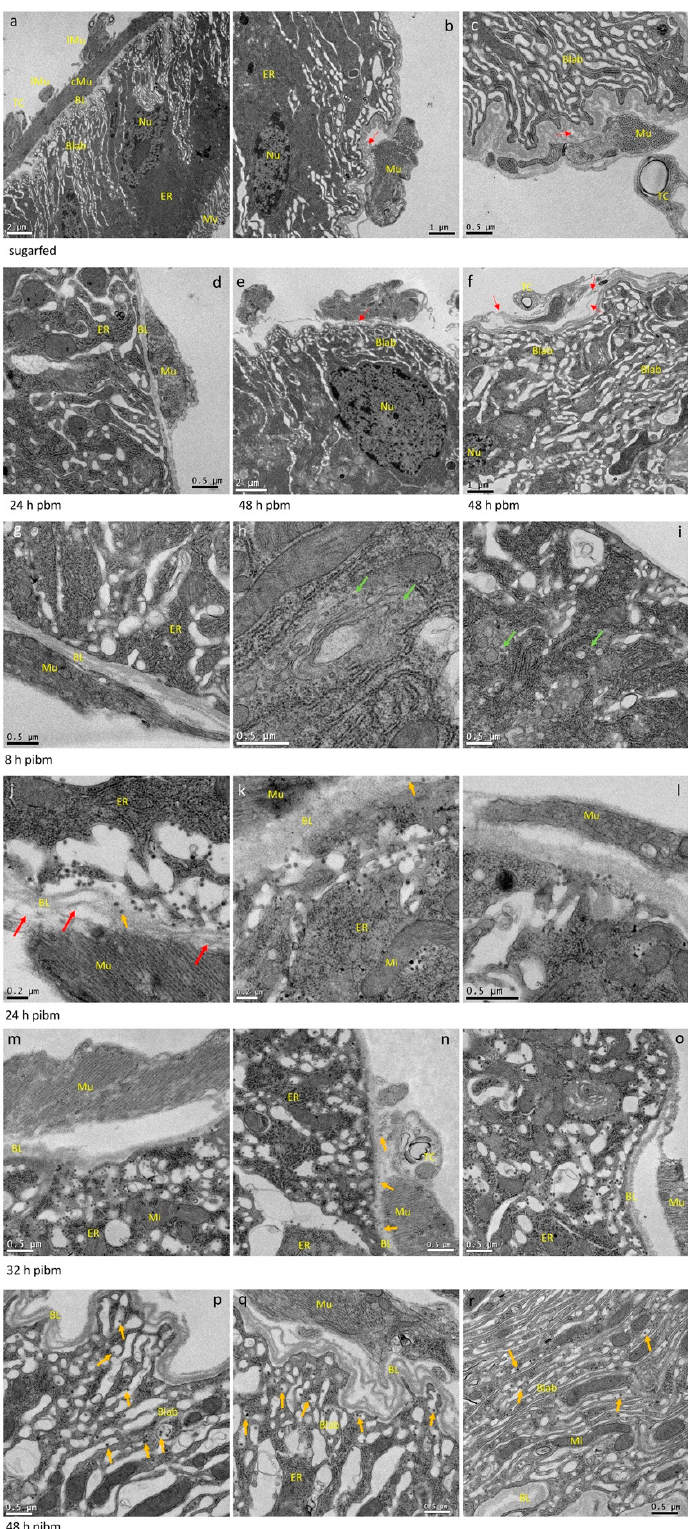
Figure 3. Ultrastructural (TEM) imaging of midgut cross-sections obtained from female Ae. aegypti , which had been sugarfed, bloodfed or orally infected with CHIKV (titer in the bloodmeal: 10 7 pfu/mL). ( a – c ) midgut cross sections of sugarfed mosquitoes. The midgut epithelium consists of a single cell layer. Luminal microvilli of an epithelial cell are visible in ( a ), followed by a dense ER containing zone, the nucleus, and a prominent basal labyrinth, which stretches out until reaching the BL surrounding the entire organ. At the hemocoel facing side of the BL (outside the midgut), circular and longitudinal muscles, as well as tracheal cells are visible. In sugarfed midguts, the BL appears